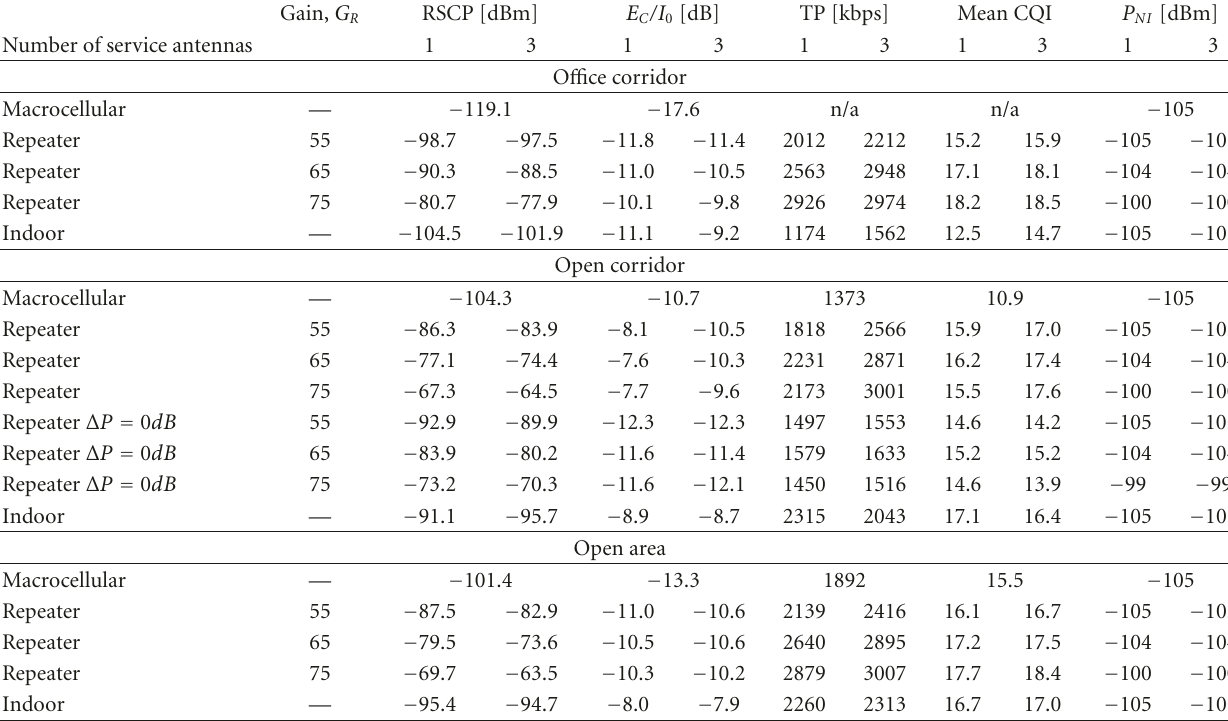
Table 2: Numerical averaged measurement